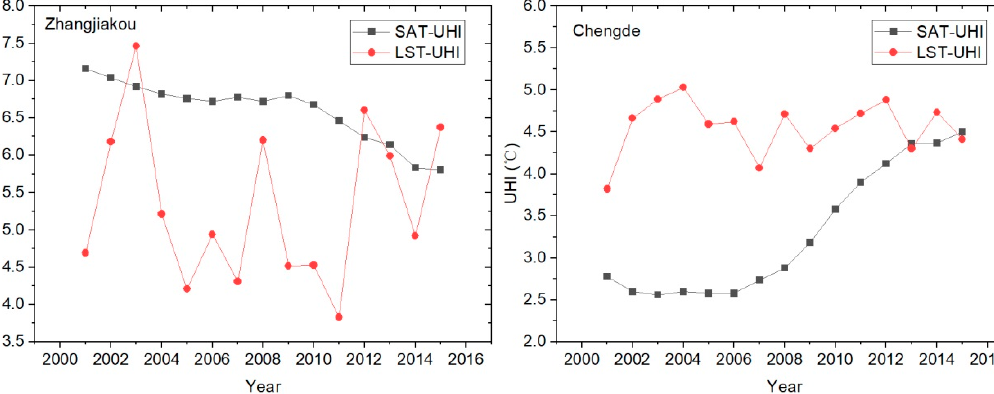
Figure 8. Temporal changes of LST-UHI and SAT-UHI in mountainous Chengde and Zhangjiakou cities.